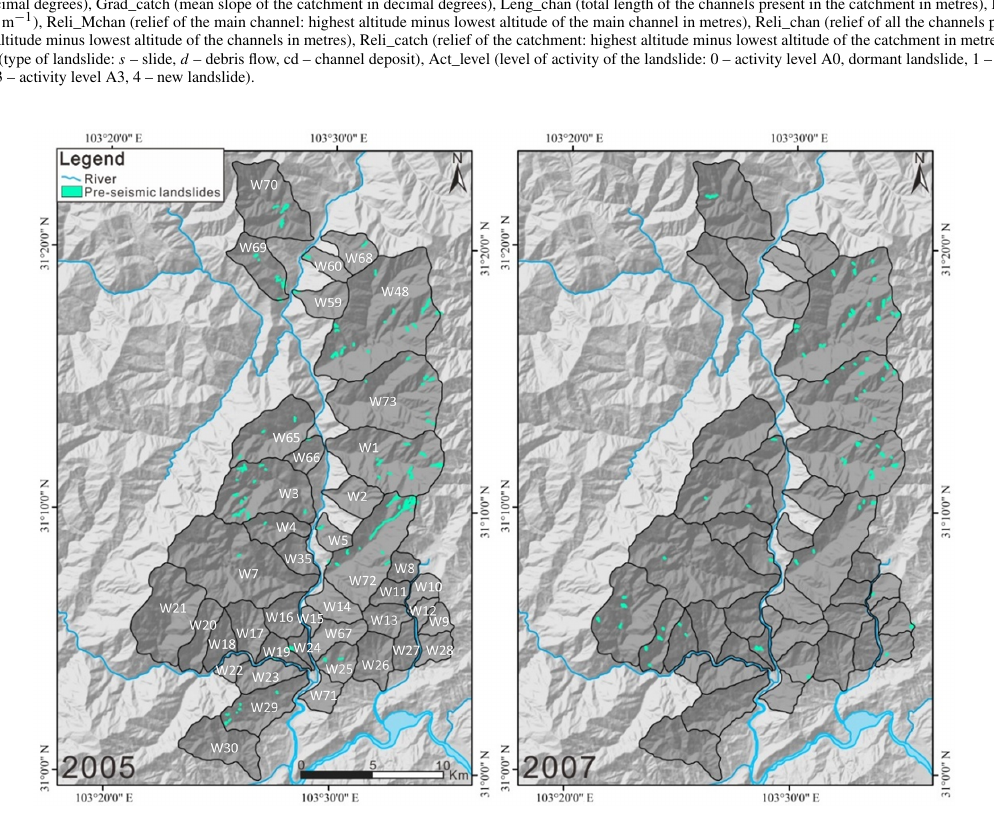
Figure 2. Landslides identified from remote-sensing images recorded in 2005 and 2007 (pre-earthquake). The identifier for each catchment (see CID in Table 1) is shown in